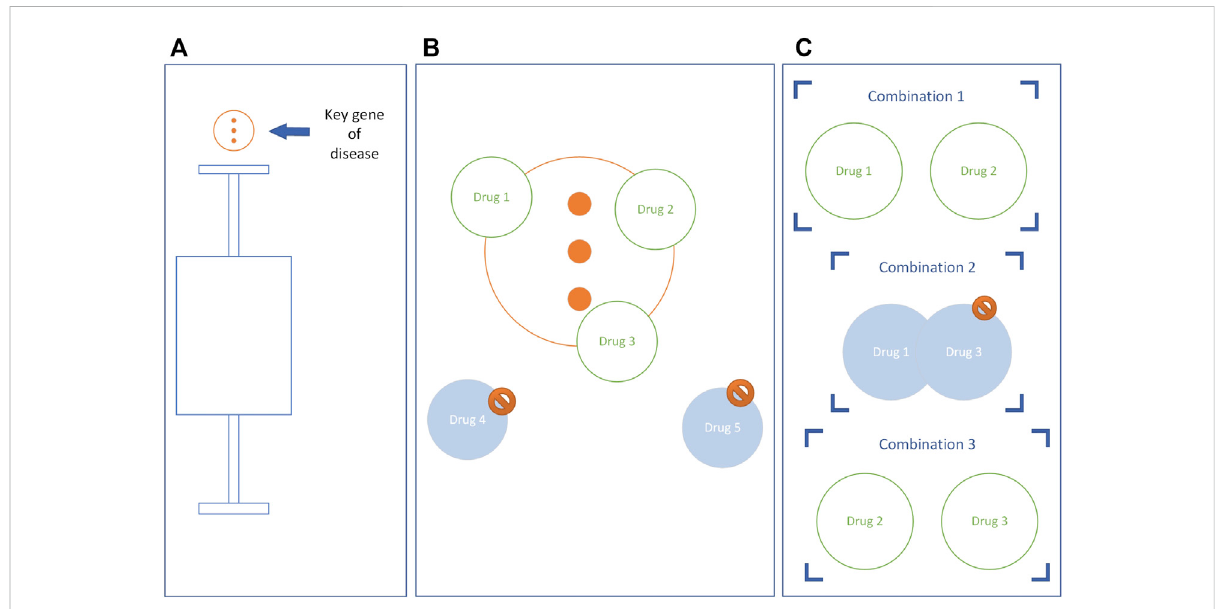
FIGURE 2 Theconstructionofthepotentialdrugcombinations.Takingthekeygenesofdiseasesasanexample,thekeypathwaysarethesame. (A) Genes abovetheupperlimitarekeygenes. (B) Eliminatedrugsthatdonothaveintersectionswithkeydiseasegenes. (C) Adrugcombinationisconstructed, and if the drugs in the combination have the same target, the combination is